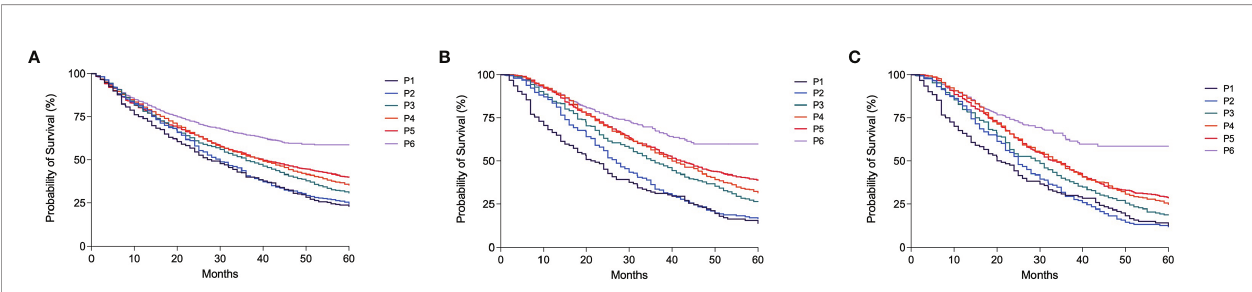
FIGURE 3 | Kaplan – Meier curves showing overall survival according to the period of diagnosis in the overall population of patients (A) , in patients treated with TACE as fi rst treatment (B) and in those treated with TACE as main treatment (C) (all p <